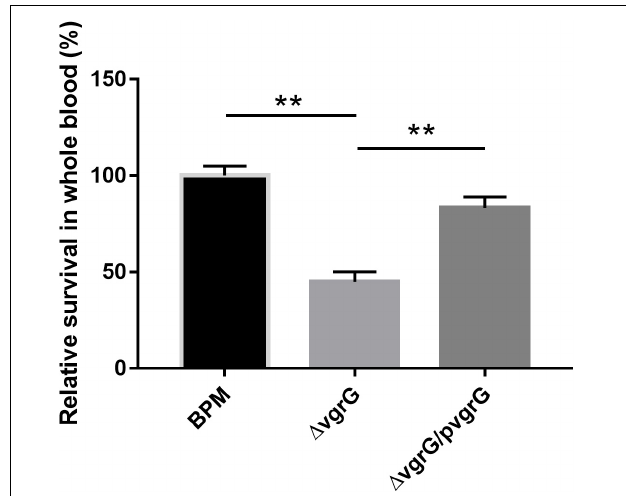
FIGURE 5 | Whole-blood bactericidal experiments of BPM, mutant and complemented strains. Survival rates of the BPM, mutant and complemented strains in human whole blood. The survival rates are expressed relative to those of BPM (100%). Means and SDs of three independent experiments performed in triplicate were calculated. Significant differences between groups are indicated: **( P < 0.01).